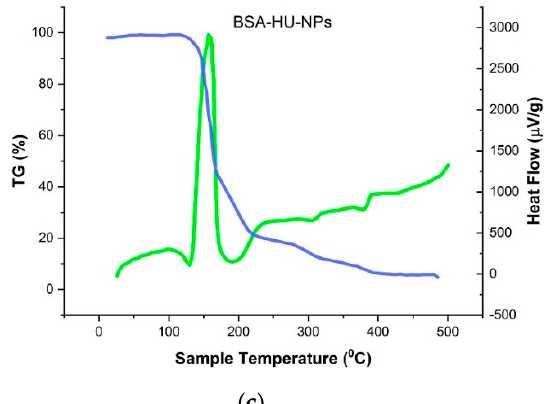
Figure 6. Thermogravimetric (blue) and differential scanning calorimetry (green). ( a ) BSA; ( b ) HU; ( c ) BSA-HU-NPs.